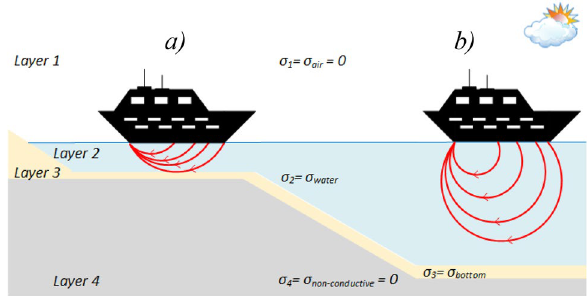
Figure 1. The four-layer model structure: layer 1—air, layer 2—water, layer 3—bottom, layer 4—non- conductive layer. Red arrows denote: ( a ) characteristic flattening of the electric field at layer 3 boundary without deep penetration into the bottom layer 4 (shallow water), ( b ) typical electric field at the deep-water